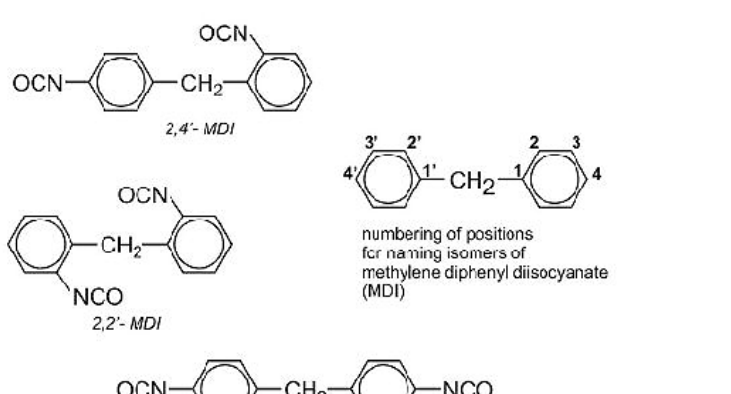
Figure 8 – A mixture of MDI Рис . 8 – Смесь MDI Слика 8 – Смеша MDI